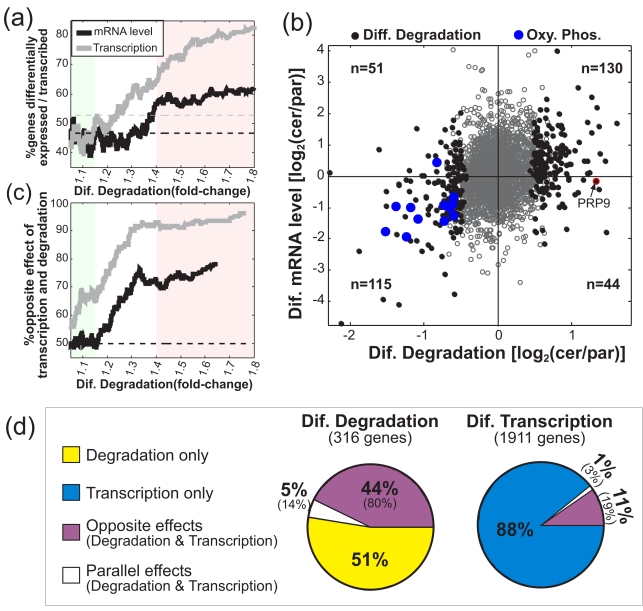
Coupled evolution of transcription and mRNA degradation.(a) Sliding window analysis (windows of 200 genes) for the percentage of inter-species differentially expressed genes (above 1.5-fold), using either mRNA levels (black) or estimated transcription rates (gray), as a function of the fold-change of inter-species differences in mRNA degradation rates. Dashed lines indicate the genome-wide percentage of differential mRNA levels (black) or transcription rates (gray). The green section includes small differences in mRNA degradation which may reflect technical variations, while the red section includes larger and biologically meaningful differences in mRNA degradation. (b) Scatter-plot of differential mRNA degradation rates versus differential mRNA levels for genes with (full circles) or without (empty circles) significant difference in mRNA degradation, and for oxidative phosphorylation genes (blue). The number of genes with significant difference in mRNA degradation is shown for each quarter, demonstrating an enrichment of genes with opposite effects of mRNA degradation and mRNA levels (genes with higher degradation in S. cerevisiae also tend to have higher mRNA levels, as the upper-right quarter has more genes than the lower-right quarter). (c) Sliding window analysis (windows of 200 genes) for the percentage of genes with opposite effects of transcription and degradation among those with differential mRNA degradation rate and either differential mRNA levels (black) or differential transcription rate (gray), as a function of the fold-change of inter-species differences in mRNA degradation rates. Dashed line indicates 50% opposite effects, as would be expected by chance if differential expression and differential degradation are independent. Green and red sections are as in (a). (d) Pie charts for the different combinations of differences in transcription and mRNA degradation, among the genes with differential mRNA degradation (right) and the genes with differential transcription (left). The analysis was performed with conservative estimates of coupling (only those with coupling as defined both by analyses of mRNA levels and by analysis of estimated transcription rates), while the percentages in parentheses show the results of a more relaxed analysis, in which either mRNA levels or transcription rates were sufficient to define coupling.